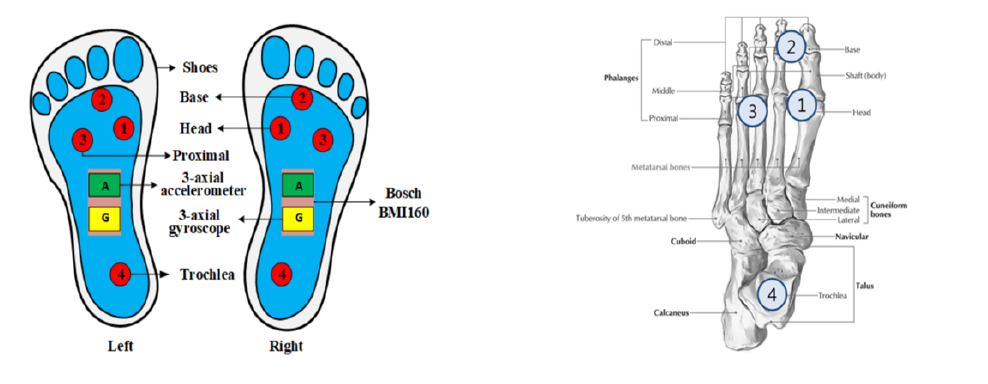
Figure 2. Locations of the sensors in the smart shoes: ( a ) a total of 12 sensors (6 sensors on the left and right shoe each) consisting of the pressure, accelerometer, and gyroscope sensors; ( b ) locations of the pressure sensors on the anatomical sketch: 1st metatarsal head (MH; sensor 1), toe (between the 1st and 2nd phalange; sensor 2), 4th metatarsal head (sensor 3), and heel (sensor 4).